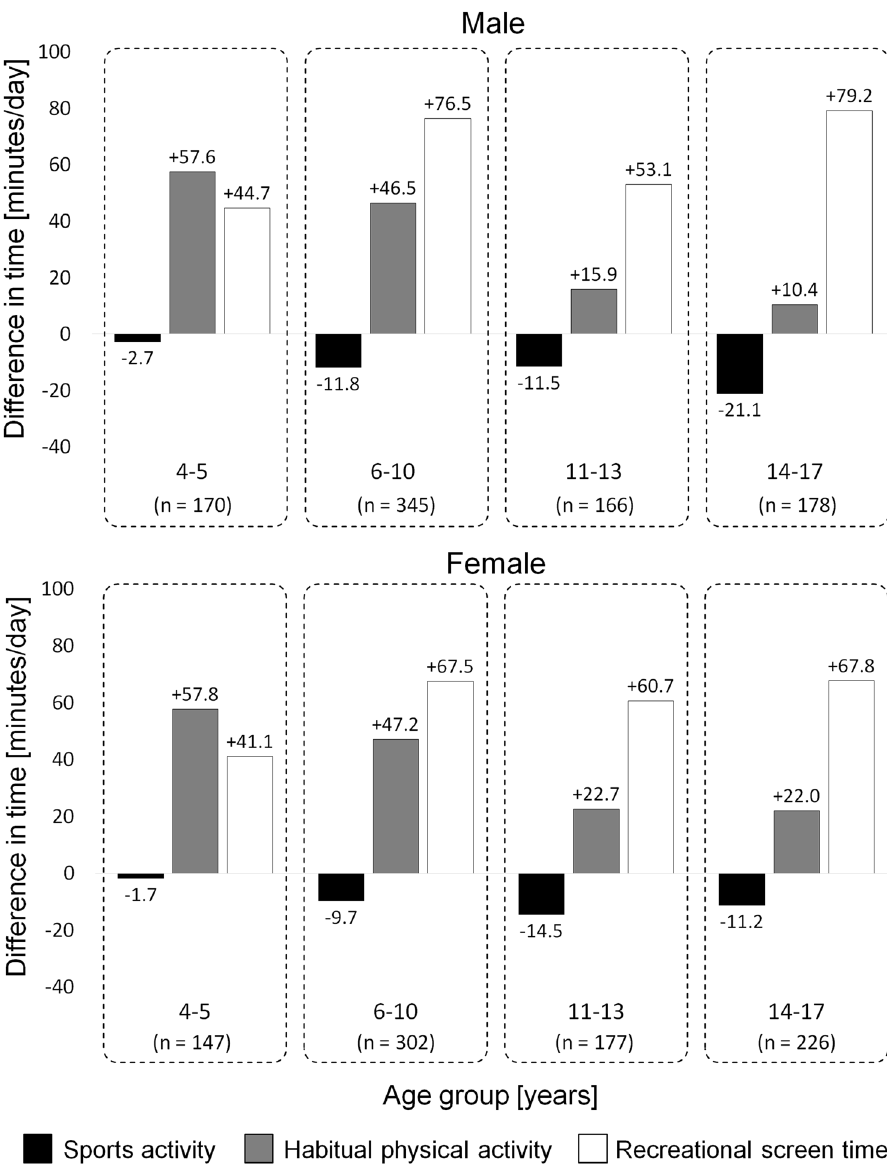
Figure 1. Differences for total amount of sports, habitual physical activity, and recreational screen time among youth in Germany pre and peri the COVID-19 lockdown (MoMo